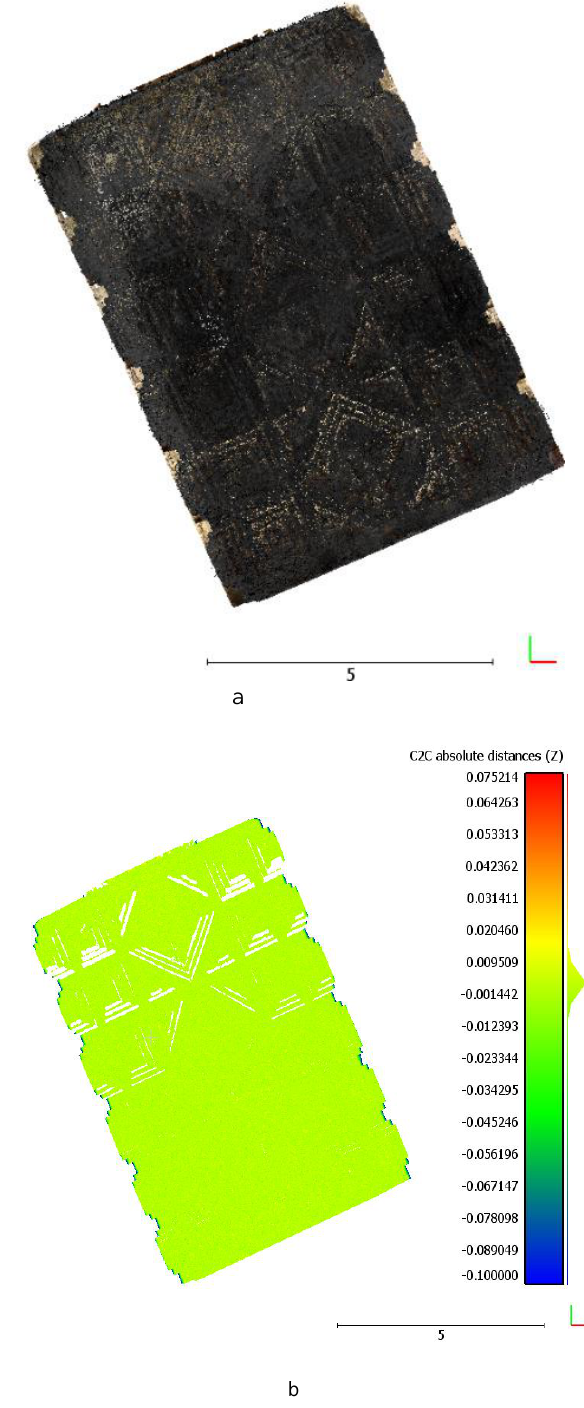
Figure 13 . Registration of the top part (a) and its distances (b) along the z axis resulting from the Cloud-to-Cloud application, the registration of the two point clouds was applied (setting shift and rotation in the three directions x, y, z. The same registration of the geoslam cloud on the laser was then performed, with shift along the x,y,z axes and rotation along all three x,y,z axes (fig. 13 a and